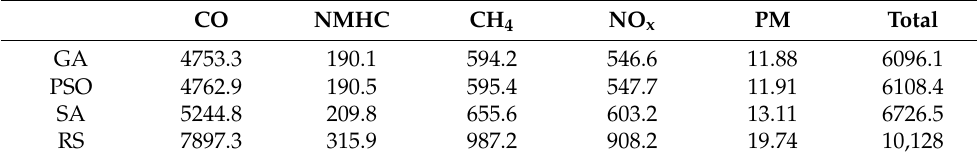
Table 8. Estimated accrued emissions in g of the case of twenty